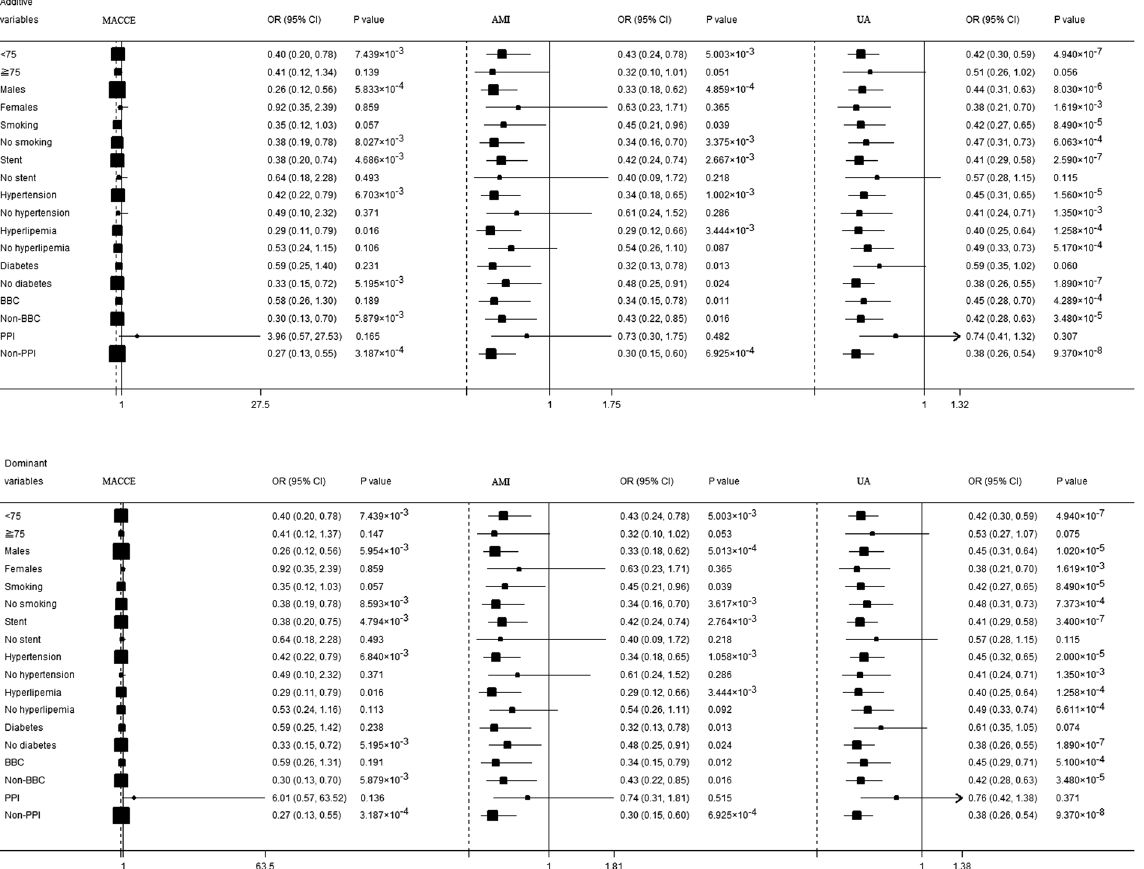
Figure 2. Association between genetic polymorphisms and clinical outcomes in acute coronary syndrome patients. Each box and horizontal line represents the odds ratio (OR) and 95% confidence interval (CI); each analysis used the C allele for reference. Eight factors were included in the analysis and all factors were adjusted for the other factors. For example, when analyzing age, the factors, including gender, smoke state, plant stent, hypertension, hyperlipemia, diabetes, BBC and PPI were